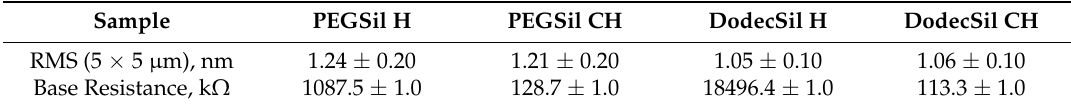
Table 3. Root mean square (RMS) roughness values calculated from 5 × 5 µ m areas between the electrodes and base resistance at room temperature (RT) in N 2 for all sensing